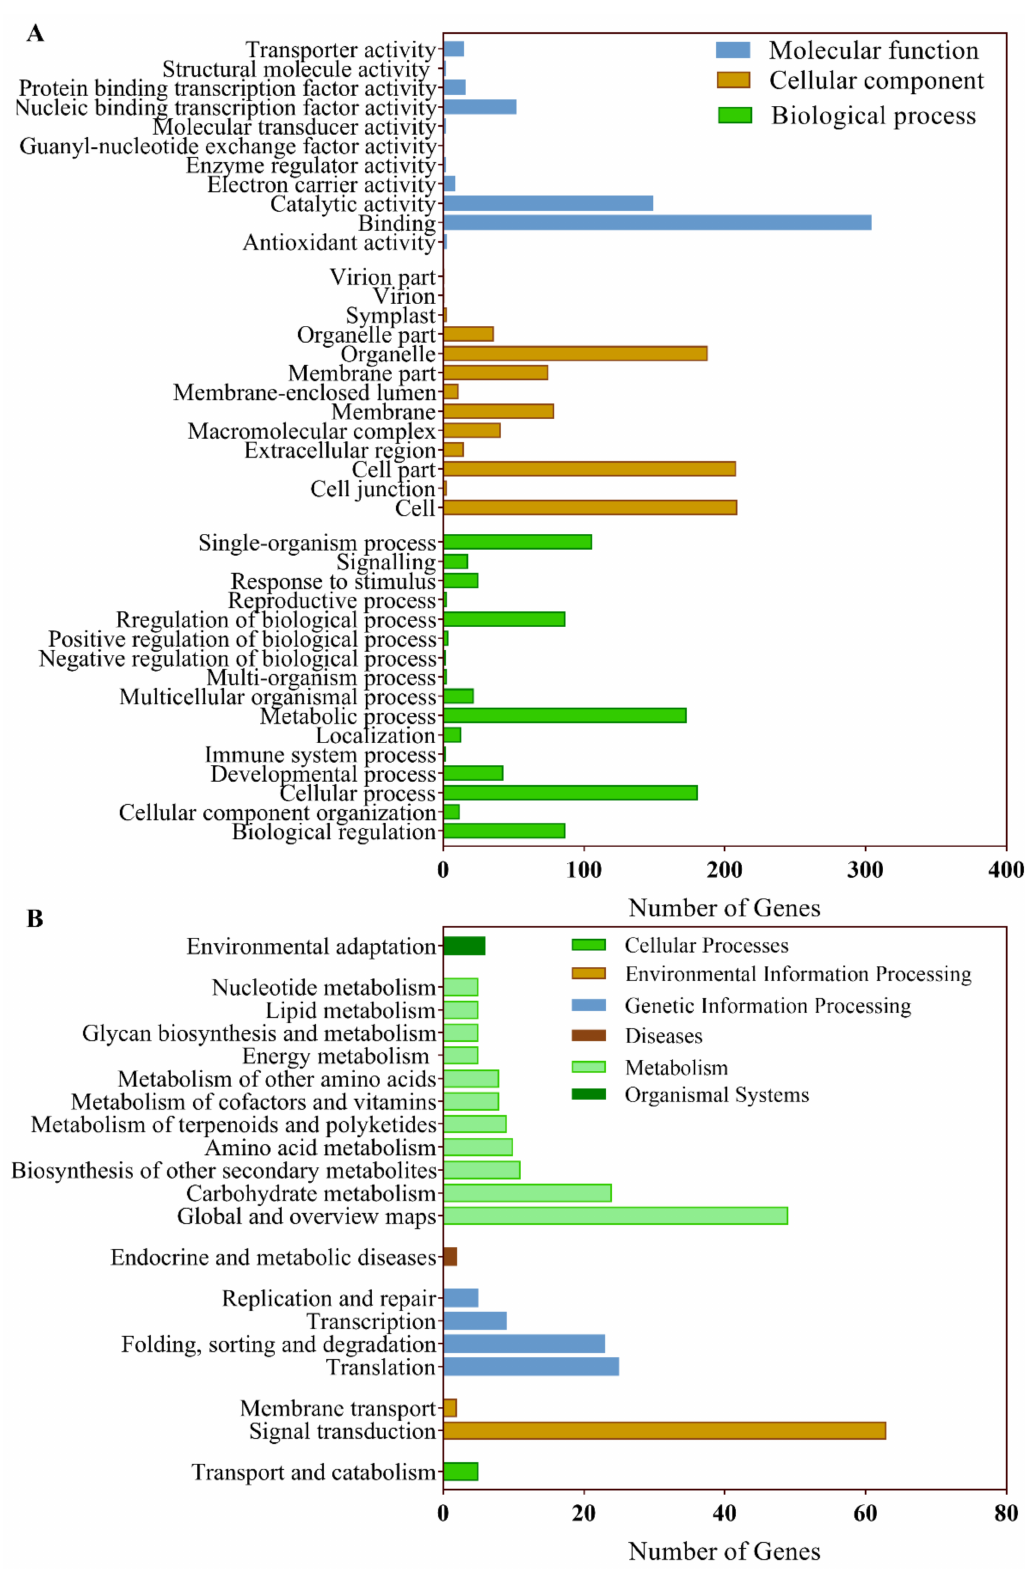
Figure 2. High-throughput small RNA and mRNA sequencing revealed abortion-related small RNAs and mRNAs in lotus flower buds. Volcano plots of differentially expressed small RNAs ( A ) and miRNAs ( B ) between the normal and aborting flower